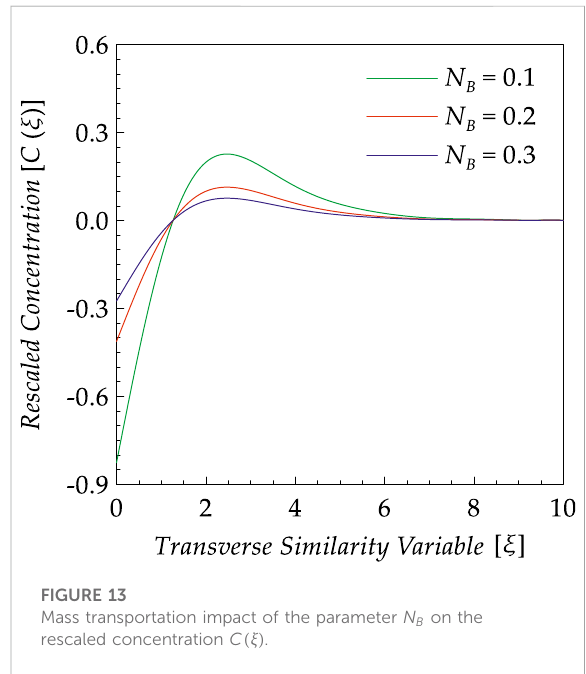
FIGURE 13 Mass transportation impact of the parameter N B on the rescaled concentration C ( ξ )